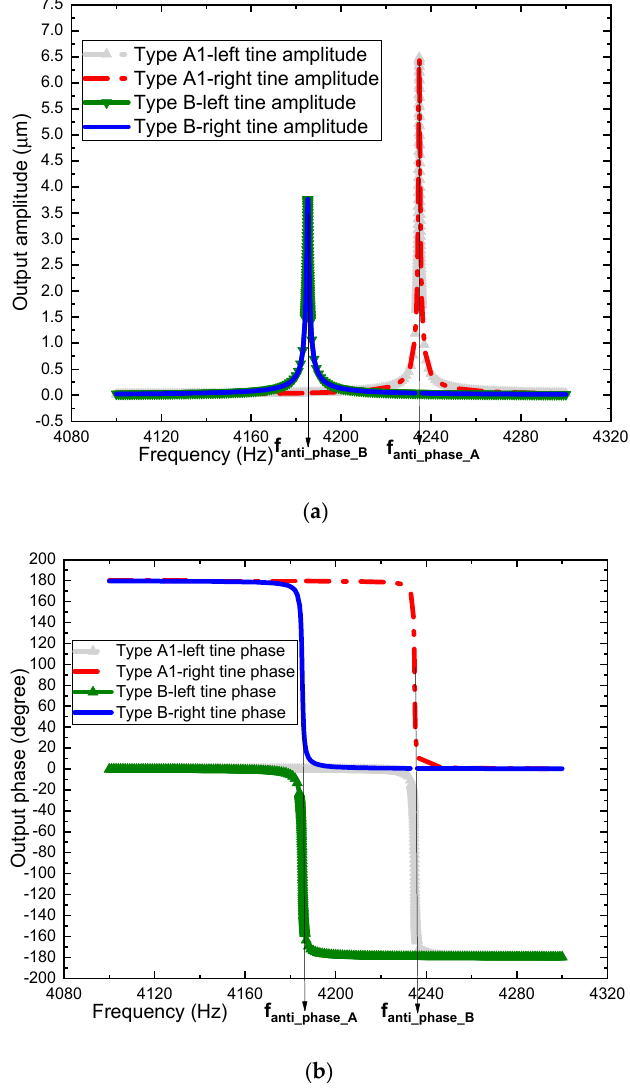
Figure 7. ( a ) Amplitude response and ( b ) phase response of types A1 and B.